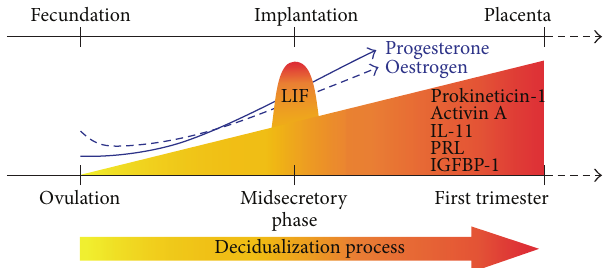
Figure 1: Temporal representation of the decidualization process starting after the ovulation phase of the menstrual cycle and progressing through the first trimester of pregnancy. Progesterone and oestrogen levels increase until the end of gestation, while the decidualization factors, prokineticin-1, activin A, IL-11, PRL, and IGFBP-1 increase in the first trimester until the complete formation of the placenta. LIF is a decidualization factor peaking at peri-